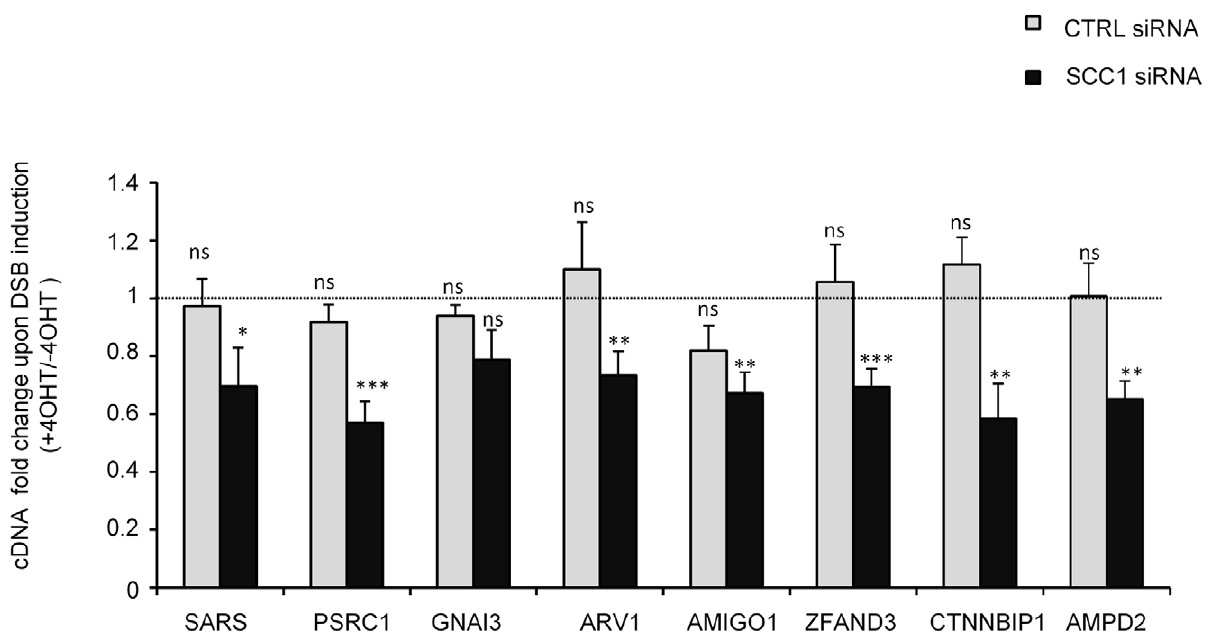
Figure 5. Cohesin is required to ensure transcriptional maintenance in c H2AX domains after 4OHT treatment. RNAs were prepared and reverse transcribed from Asi SI-ER-U20S cells transfected with control or SCC1 siRNA before and after 4 hours of 4OHT treatment (as indicated). cDNA levels for several genes encompassed in c H2AX domains were measured by Quantitative PCR. Data were normalized against P0 (ribosomal protein) cDNA. Data were expressed as cDNA fold change between 4OHT treated and untreated cells. The mean and SDOM from five independent experiments are shown. The p value above each bar indicates one sample t-test against a theoretical ratio of 1 (no change between + 4OHT and 2 4OHT) (* p , 0.1, ** p , 0.05, *** p ,